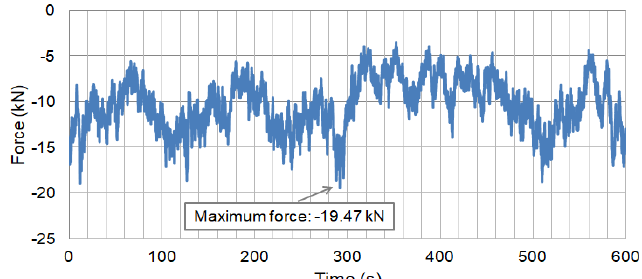
Figure 9. Typical example of nondeterministic wind loading in the time domain (period of recurrence of 10 years).